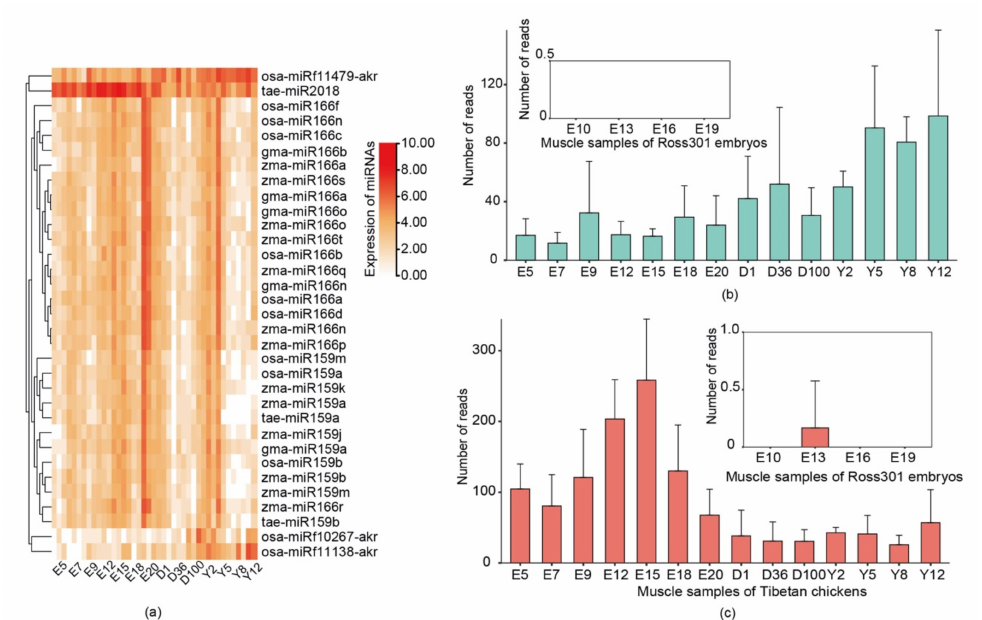
Figure 2. Expression of plant miRNAs across different chicken developmental stages. ( a ) Heatmap showing the expression of plant miRNAs with more than 40 reads. Expression levels (read counts) of osa-miRf11479-akr ( b ) and tae-miR2018 ( c ) at 14 chicken developmental stages. Note: ‘E’, ‘D’, and ‘Y’ indicate the sampling times in ‘embryonic days’, ‘days after hatching’ and ‘years’, respectively. Expression of plant miRNAs in Ross301 chicken feed without exogenous plant miRNA is also